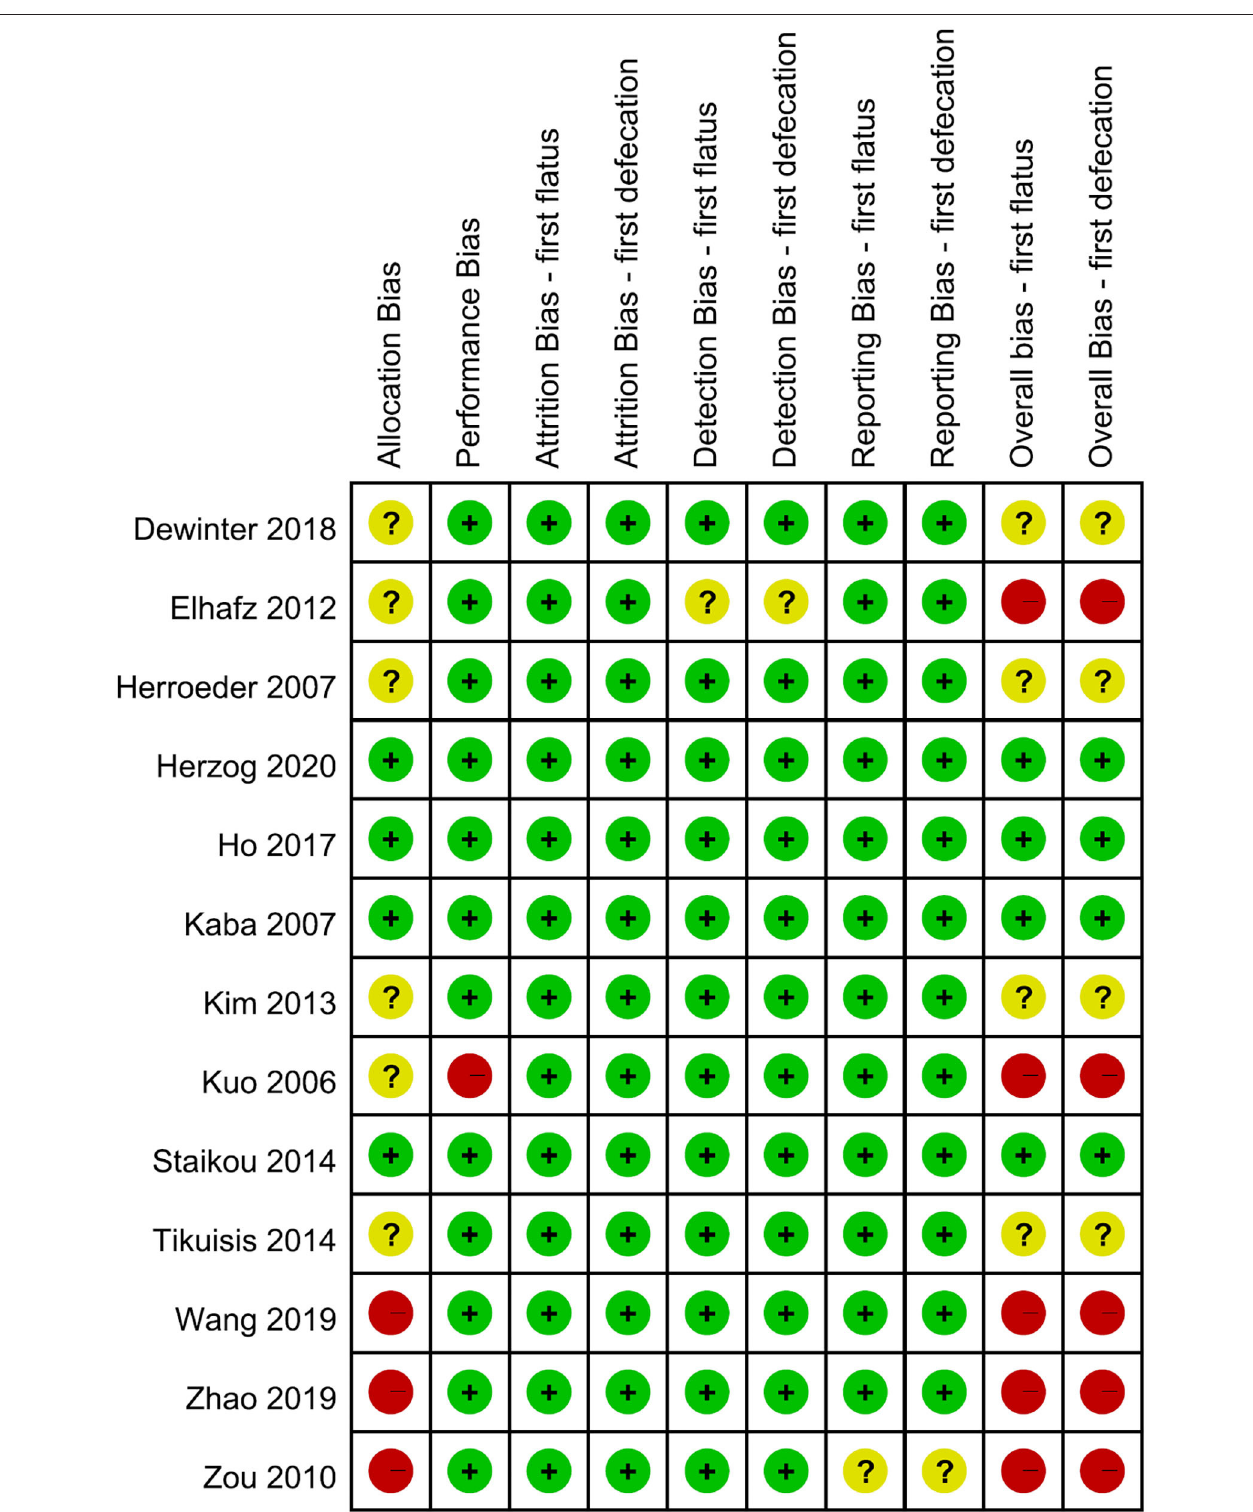
FIGURE 2 | Risk of bias across all included RCTs using the Cochrane RoB 2.0 tool.